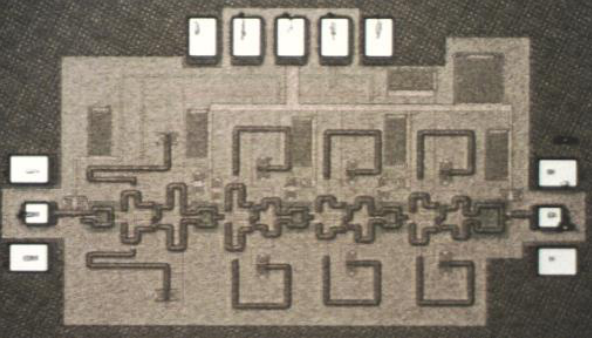
Figure 11. Chip microphotograph of the W-band amplifier.